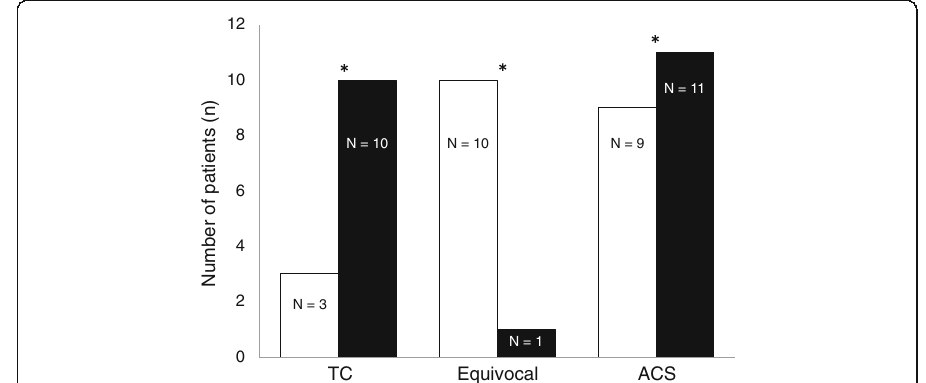
Fig. 4 Alteration of image interpretation (TC or non-TC) between SPECT-only (white columns) and SPECT/ CT fused (black columns) analyses